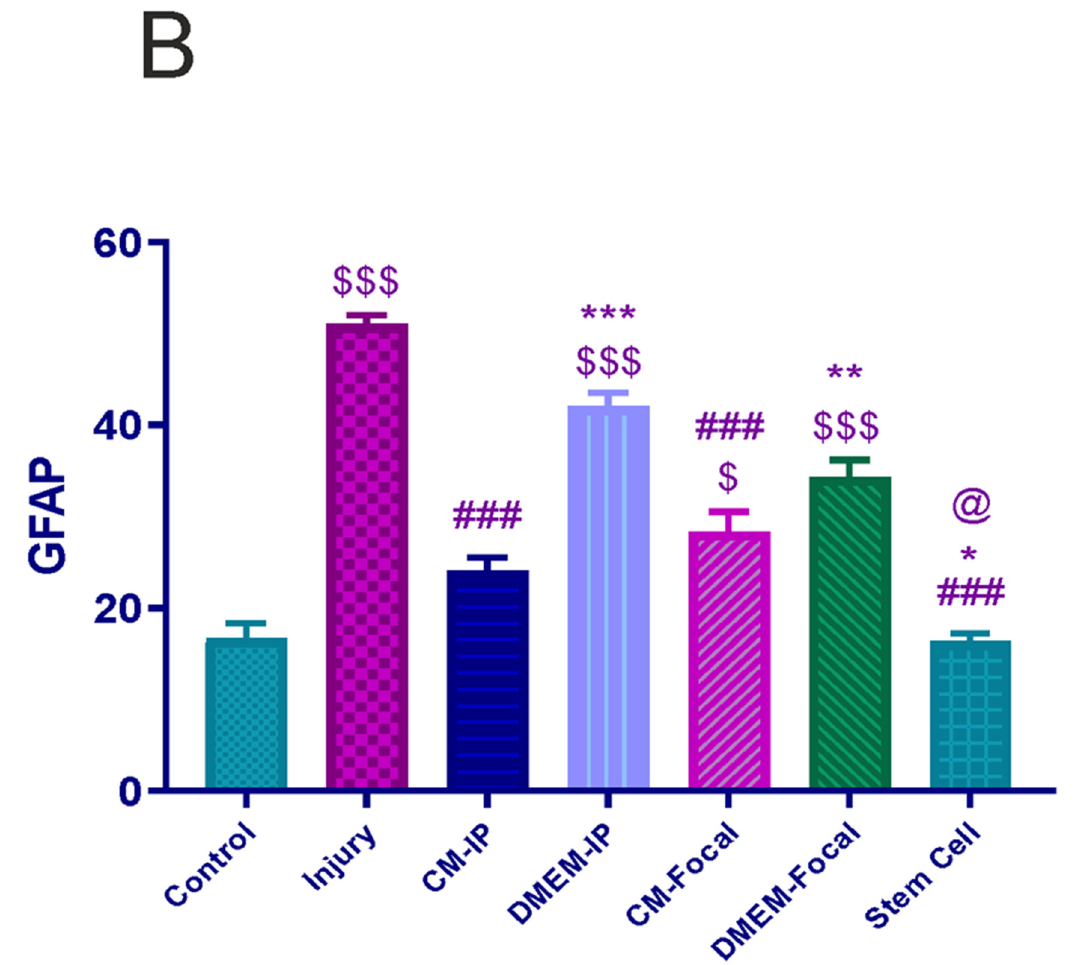
Figure 4. Immunofluorescence staining within two weeks’ post-injury for GFAP . ( A ) The double staining of GFAP for the effect of hAFMSCs-CM on GFAP in spinal cord injury by confocal microscopy. GFAP -positive astrocytes (red, 2 weeks’ post-injury) is detected in the spinal cord. Nuclei were counterstained with DAPI (blue). After SCI treatment with CM in the form of IP and Focal, the stem cells showed a significant decrease in GFAP ( p < 0.001). Data represent means ± SEM. Scale bars = 20 µm. ( B ) The quantification of immunostaining data showed a decrease in GFAP + cells within different groups. $$$ p < 0.001, versus control. ### p < 0.001, versus injury. *** p < 0.001, ** p < 0.01, * p < 0.05, versus CM-IP. @ p < 0.05 versus CM-Focal.